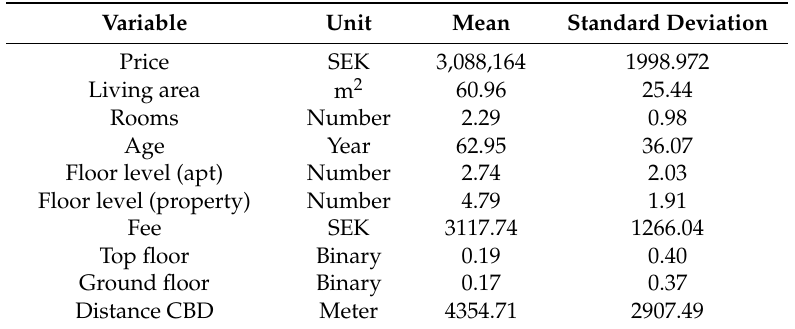
Table 1. The descriptive statistics apartment